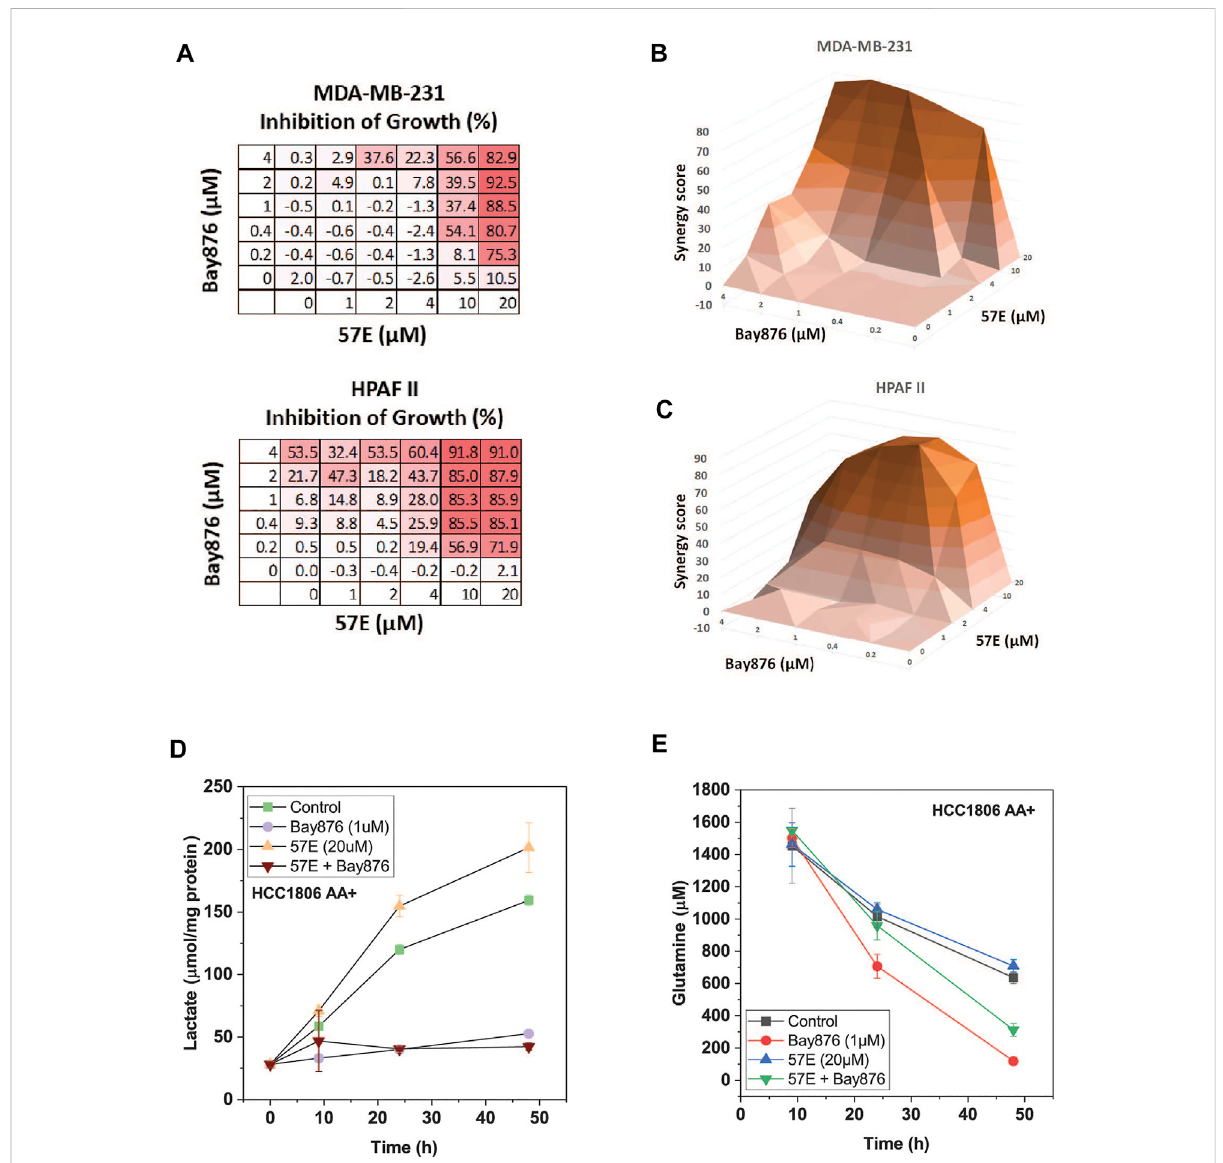
FIGURE 7 Compound 57E reduces cancer cell growth in synergy with Bay-876. Synergy between Bay 876 and compound 57E was evaluated by monitoring growth of MDA-MB-231 and HPAFII cells in the presence of different concentrations of both compounds. (A) Dose-response map of MDA-MB-231andHPAF2cells. (B,C) Isobologramanalysis ofMDA-MB-231 (B) and HPAFII (C) cellgrowth inthepresenceofvariable concentrations of Bay-876 and 57E. For each combination the growth of the treated cultures was compared to the untreated control cultures once the latter reached > 95% con fl uence. ZIP synergy scores were calculated using SynergyFinder. Averages are shown, (n = 3). (D) Lactate production in the supernatant of HCC1806 cells was determined by an enzymatic assay. Cells were treated with Bay-876 (1 μ M) and/or 57E (20 μ M) for 24 h and samples were analysed at the indicated hours (n = 3). (E) Glutamine was determined using LC-MS. Samples were taken from media supernatant of HCC1806 cells treated with Bay-876 (1 μ M) and/or compound 57E (20 μ M) for 24 h or 48 h (n =